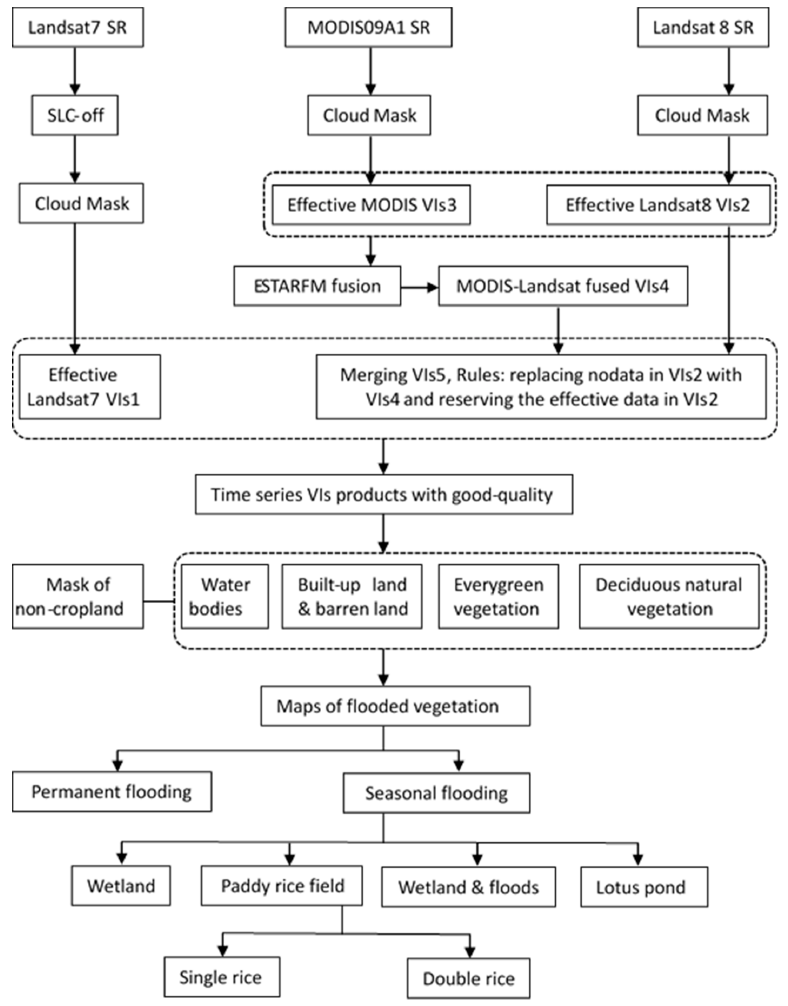
Figure 2. Flowchart illustrating the algorithm used for mapping rice paddies and multi-cropping areas.